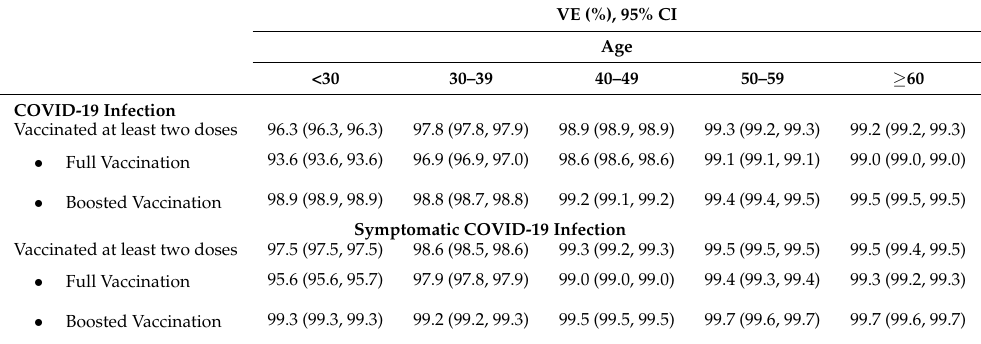
Table A2. Age-stratified estimation of VE against COVID-19 infections using screening